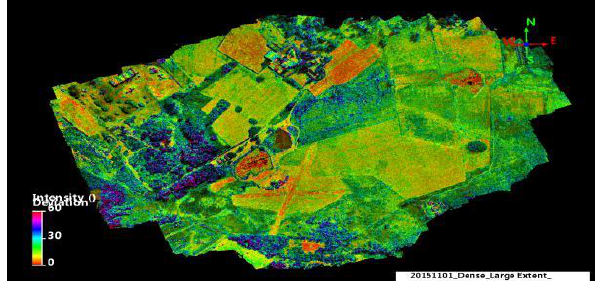
Figure 10. QTM intensity deviation point